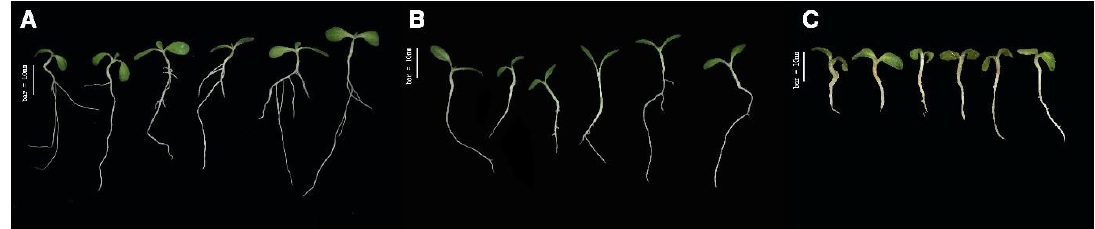
Figure 2. Allelopathic effect on growth inhibition of lettuce: ( A ) lettuces cultivated without rice control; ( B ) lettuces cultivated with rice ‘Nong-an’; and ( C ) lettuces cultivated with rice ‘Sathi’.